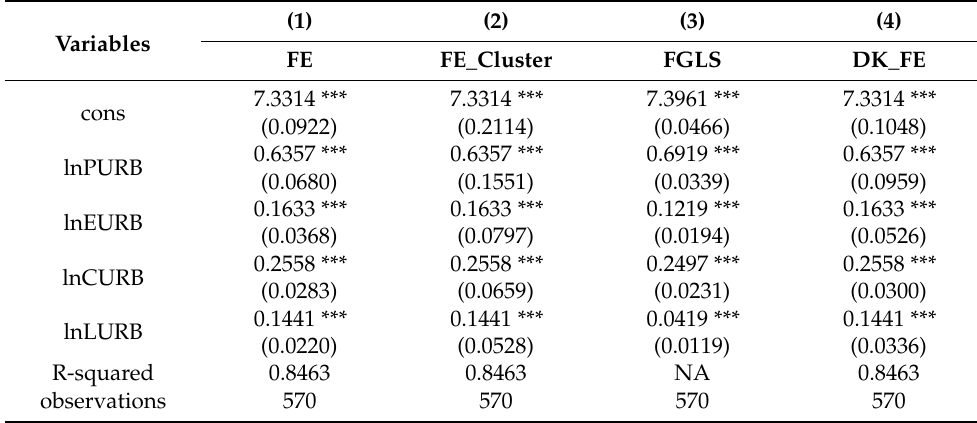
Table 10. Estimation results of whole regions’ panel data.